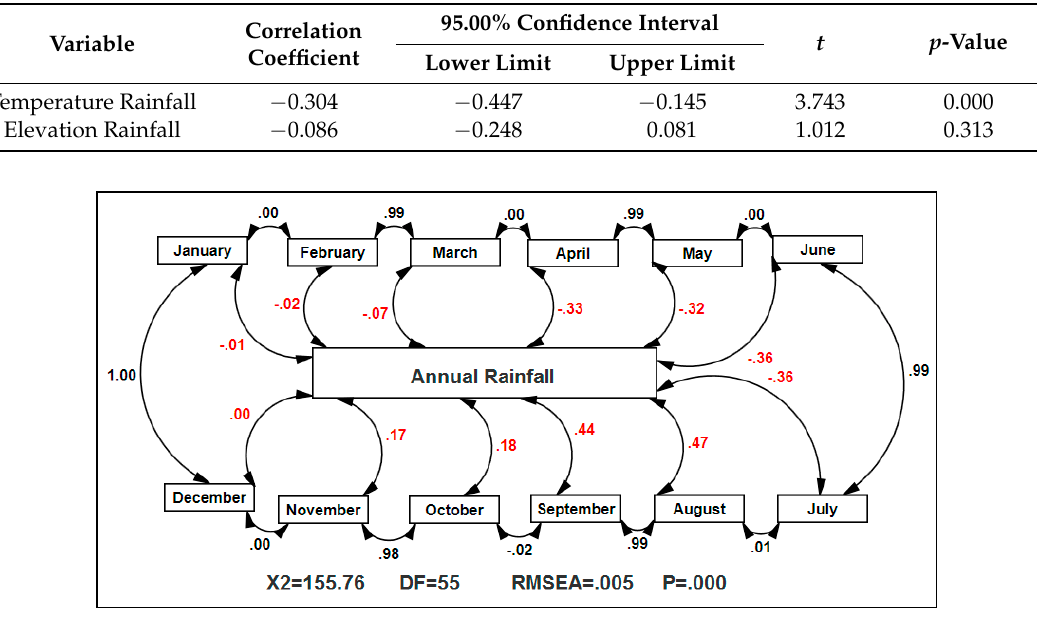
In Figure 7, the double-headed arrows indicate covariance or correlation between pairs of variables.